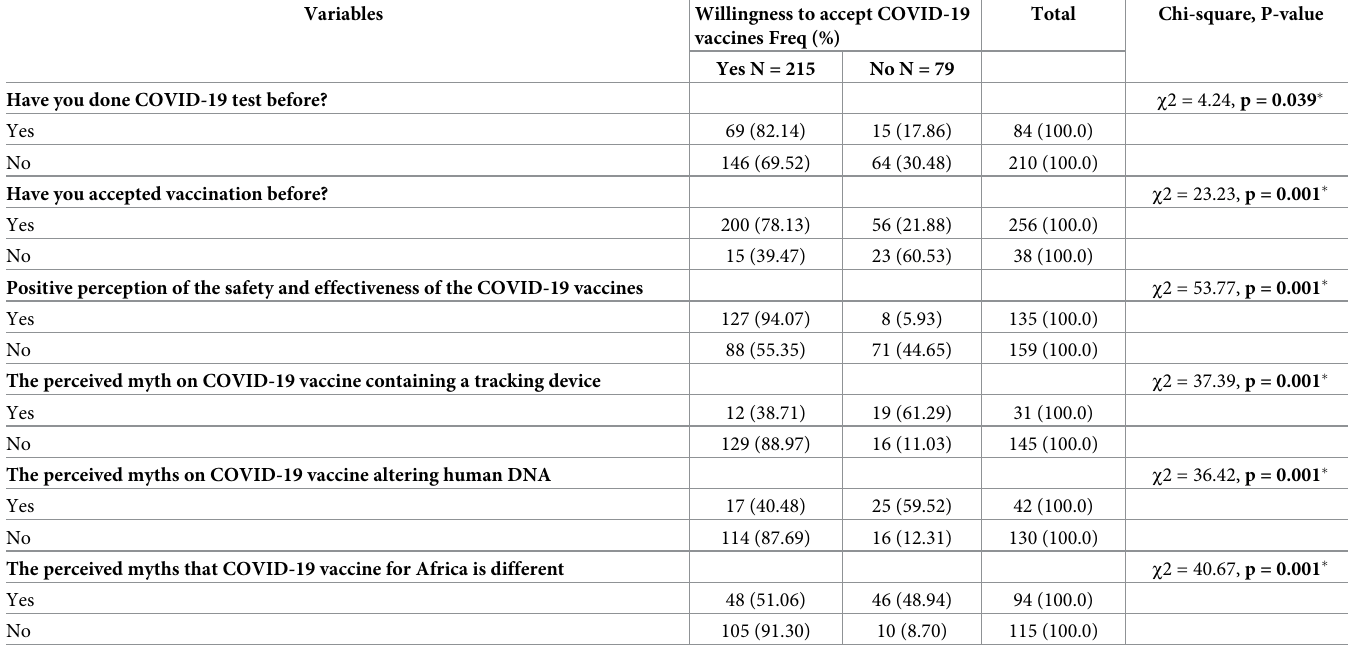
Table 8. General factors associated with the willingness to accept COVID-19 vaccines (n = 365).